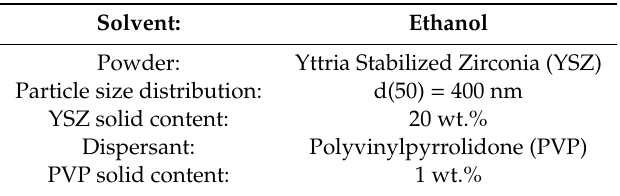
Table 1. Homemade suspension parameters.